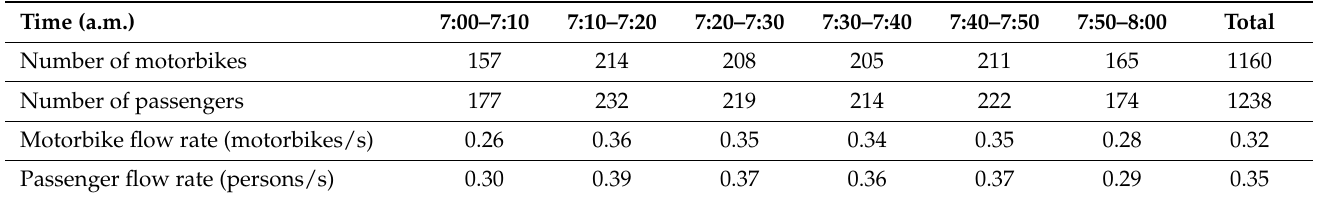
Table 5. Traffic flow of Cross-Harbor Tunnel motorbike lane during rush hour (Date: 18 January 2016). Time (a.m.)